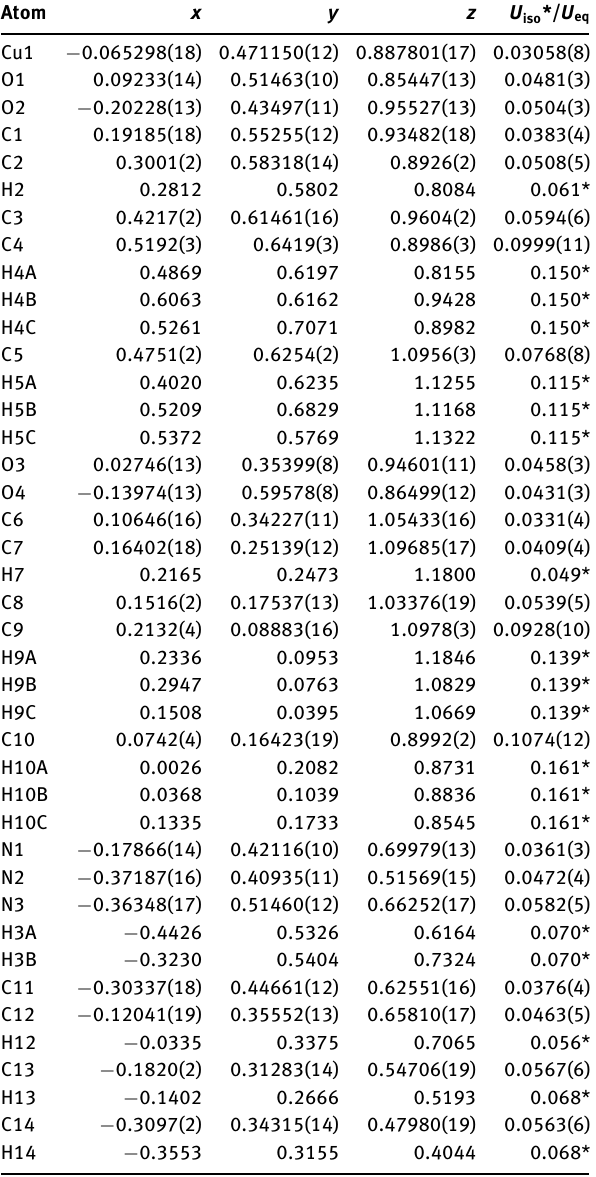
Table 2: Fractional atomic coordinates and isotropic or equivalent isotropic displacement parameters (Å 2